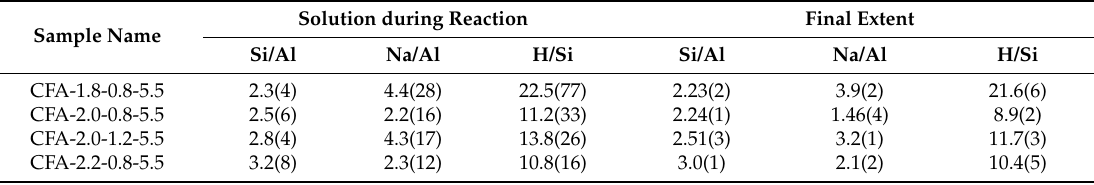
Table 4. The mean atomic ratio in the solution during geopolymer phase growth (between 10% and 90% of relative GP concentration); and the mean final extent ratio. The statistics were weighted by time. The final extent ratios are the mean of the last 15 patterns. Note, the formation of geopolymer and zeolite-like phases was not accounted for as the specific chemistry was not known.